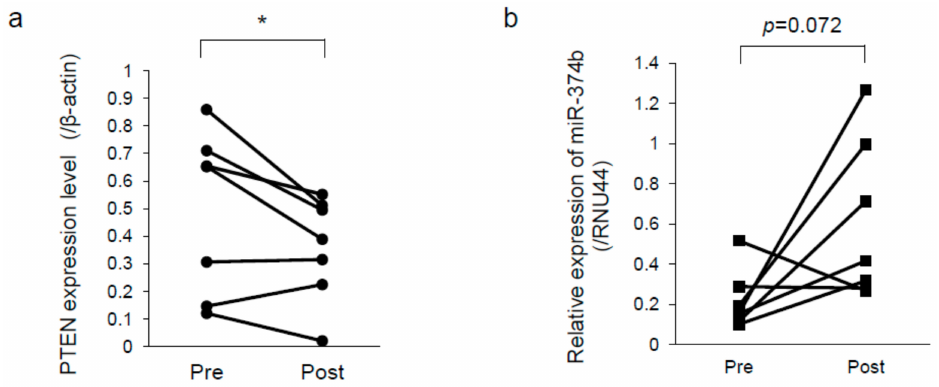
Figure 6. Expression levels of PTEN protein ( a ) and miR-374b ( b ) in the melanoma tissues that had spontaneously developed in the oral cavity of dogs. The tissues were harvested before radiation therapy and at recurrence. * p < 0.05, for di ff erences between the bracketed